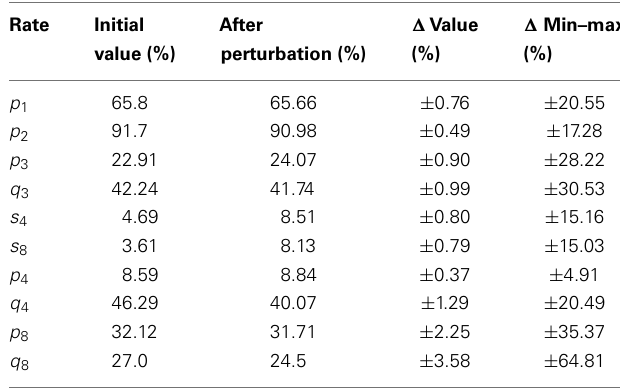
Table 3 | Selection rate values (initial and after perturbation) and their variability